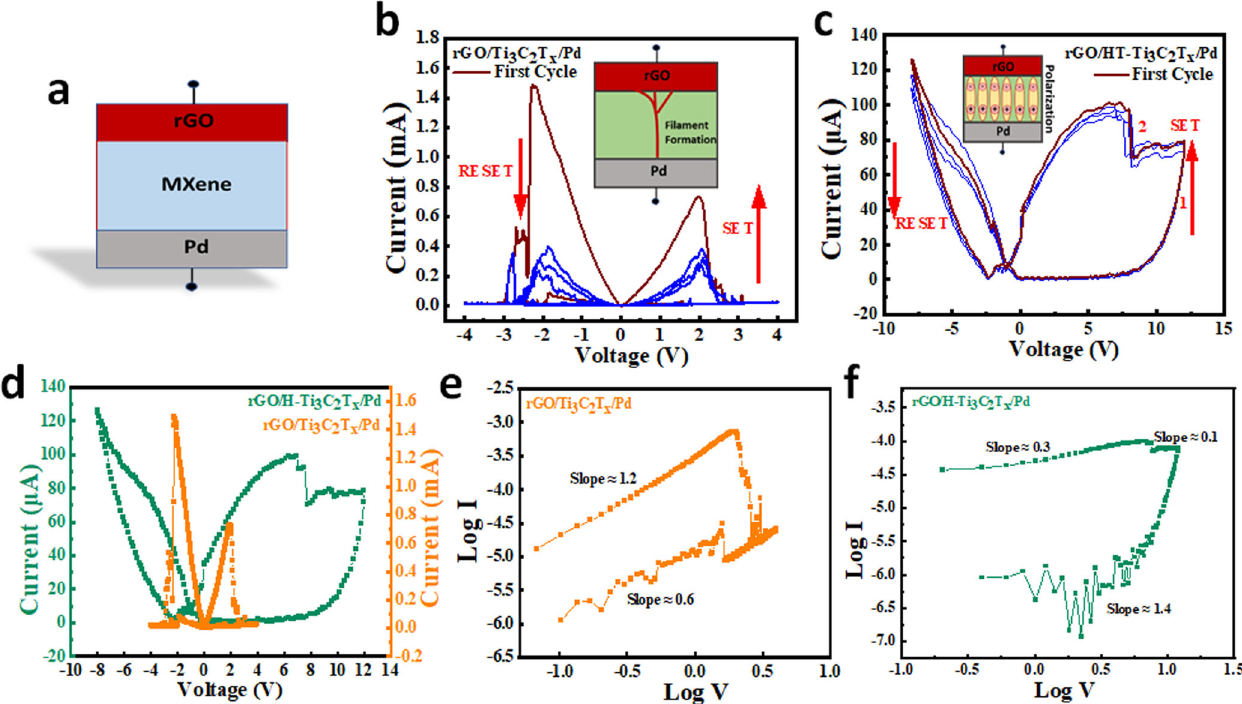
Fig. 6 Memory device testing. a Schematic representation of trilayer memory device. b Resistive switching behavior of rGO/Ti 3 C 2 T x /Pd. c Resistive switching behavior of rGO/HT-Ti 3 C 2 T x /Pd. d First cycle of both rGO/Ti 3 C 2 T x /Pd and rGO/HT-Ti 3 C 2 T x /Pd memory devices. e Double logarithmic graph of rGO/Ti 3 C 2 T x /Pd. f rGO/HT-Ti 3 C 2 T x /Pd memory